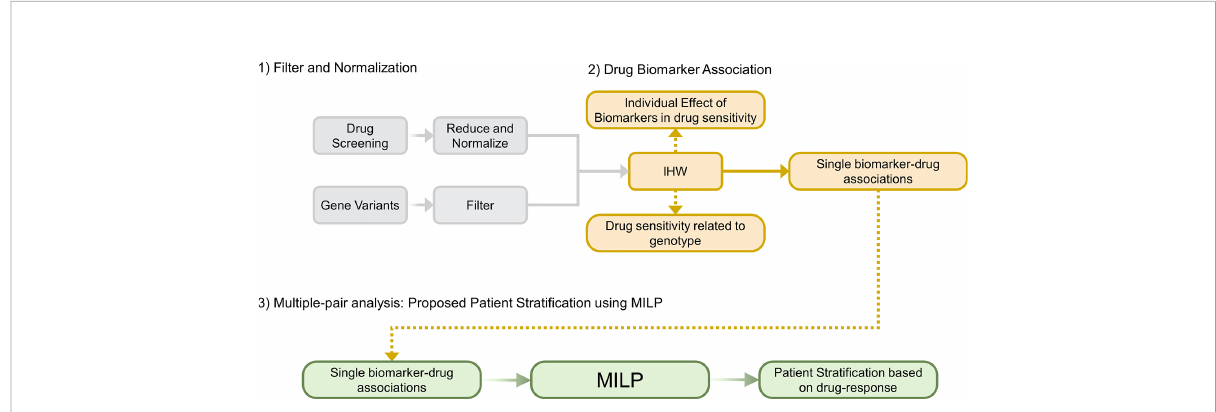
FIGURE 1 Overview of MOM ’ s pipeline. (1) Filter and Normalization. (2) Generate individual Drug-Biomarker Associations using IHW, (3) Multiple-pair analysis that generates a patient strati fi cation guideline using a novel MILP model (IHW: Independent Hypothesis Weighting, MILP: Mixed-integer Linear